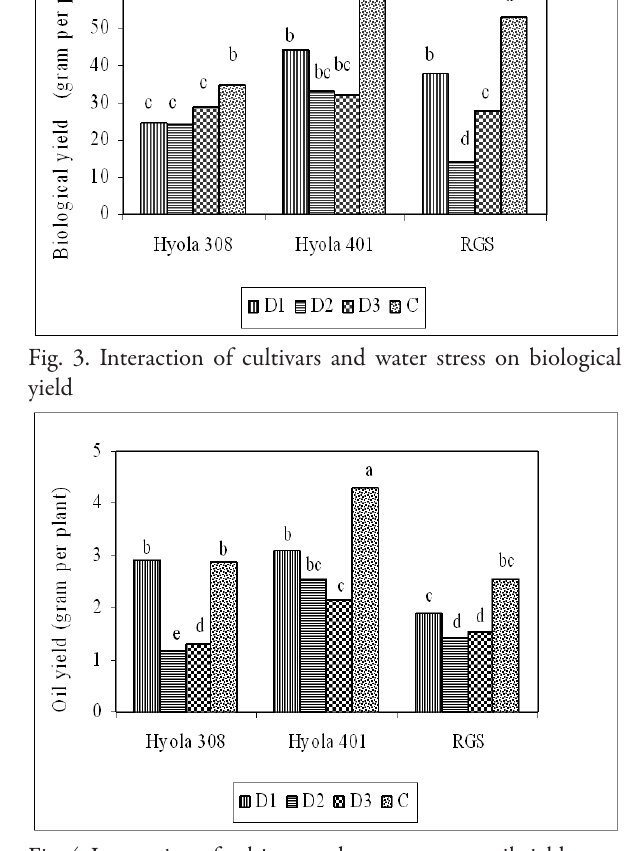
Fig. 4. Interaction of cultivars and water stress on oil